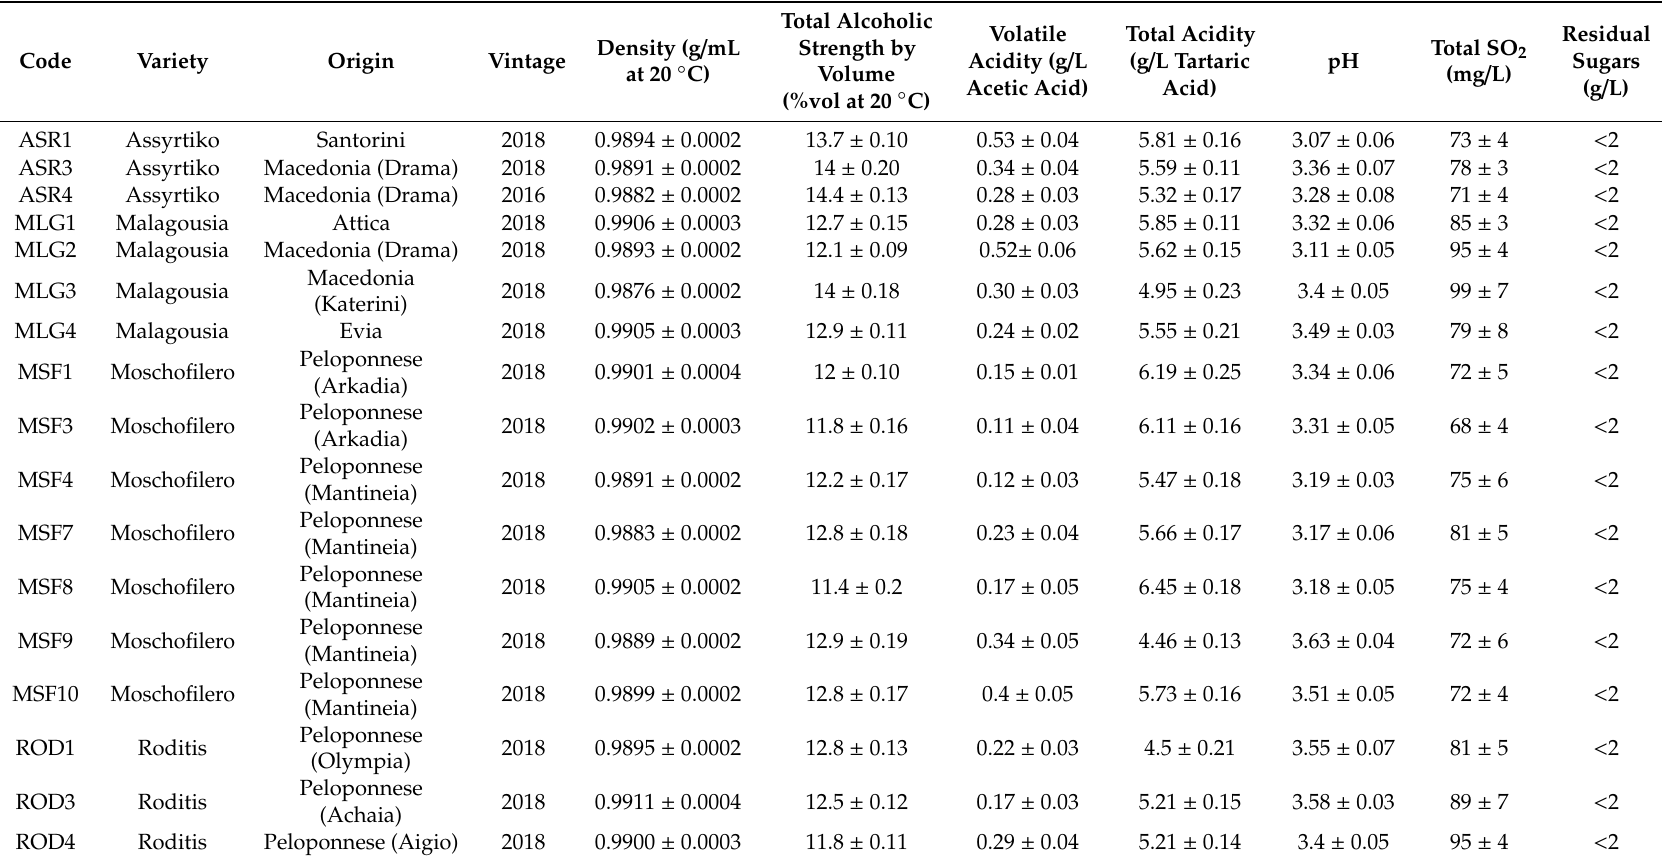
Table 1. Wine samples included in the study, along with their physicochemical characteristics